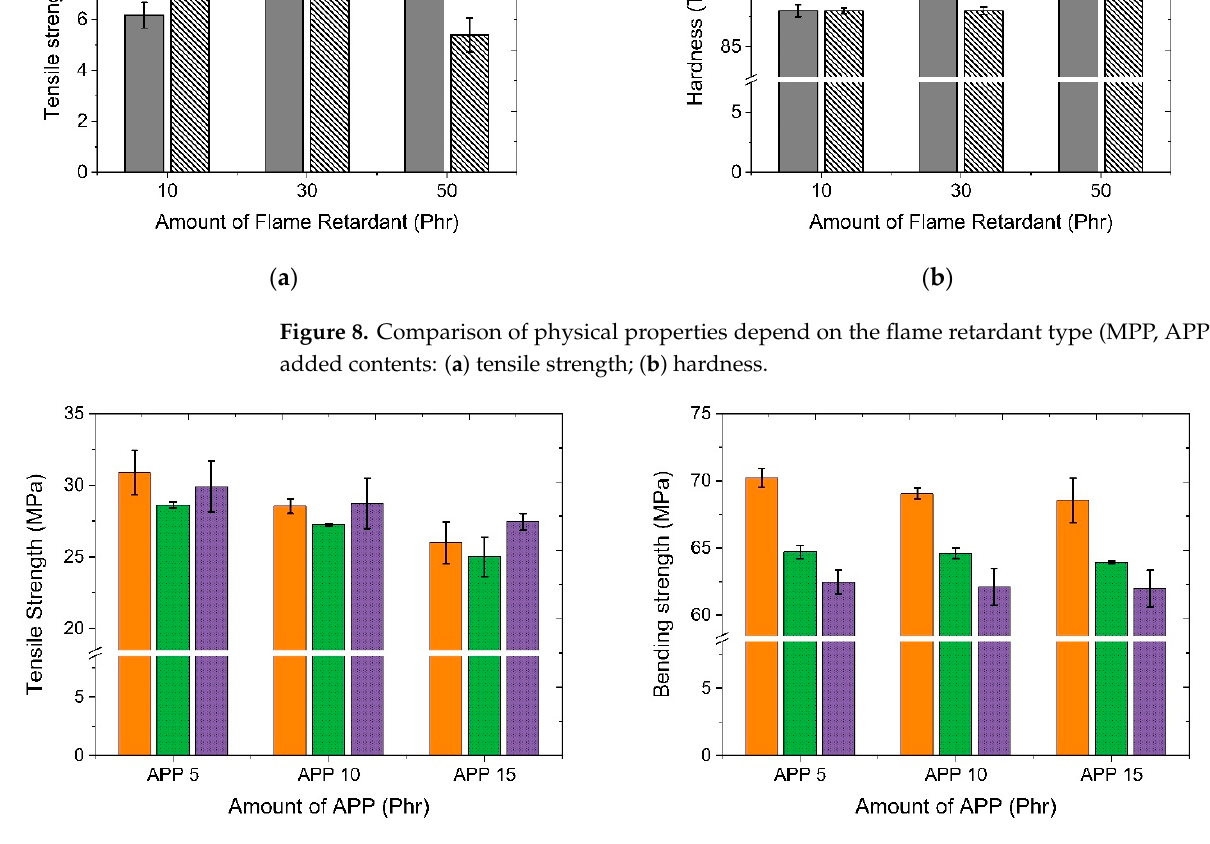
Figure 9. Comparison of physical properties as a function of the addition amount of APP flame retardant and modified flame retardants: ( a ) tensile strength; ( b ) hardness. retardant and modified flame retardants: ( a ) tensile strength; ( b )